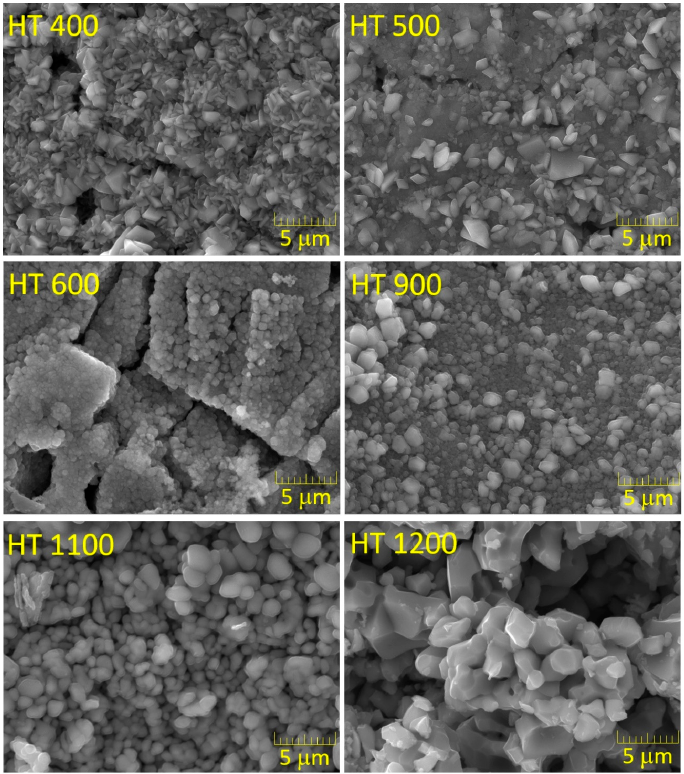
Materials 2023 , 16 , x FOR PEER REVIEW Figure 7. SEM micrographs of the samples prepared via the colloidal gel method.